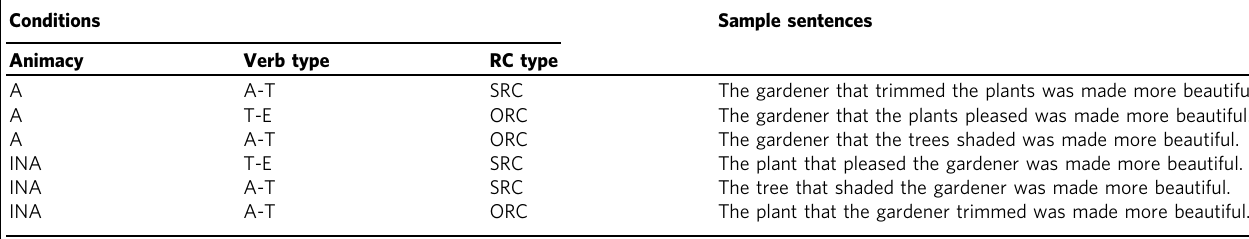
Table 3 Examples of materials for Experiment 2.